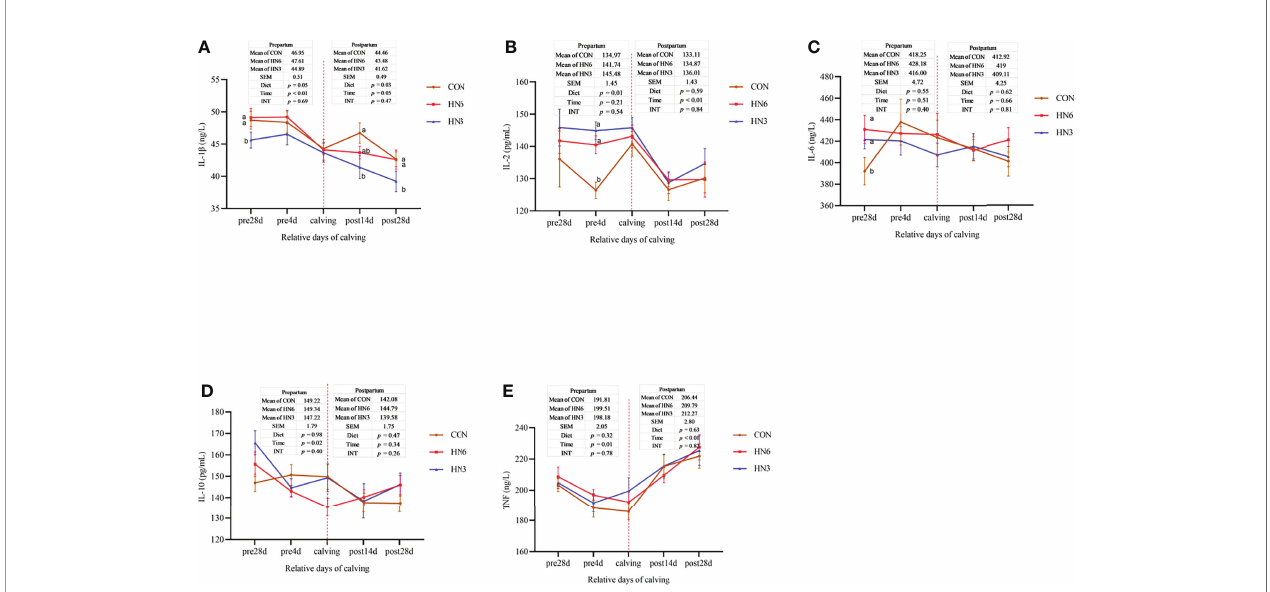
FIGURE 5 | Blood in fl ammatory cytokines in maternal cows. CON: control treatment (saturated fatty acid source), n = 12. HN3: extruded fl axseed treatment (n-3 PUFA source), n = 12. HN6: extruded soybean treatment (n-6 PUFA source), n = 13. SEM, standard error of the mean; Diet, diet treatment effect; Time, the calving time effect; INT, the interaction effect between diet effect and time effect. IL, interleukin; TNF, tumor necrosis factor. (A – E) : the different blood in fl ammatory cytokines in maternal cows. Values in the same sampling time point between treatments denoted by different superscript lowercase letters indicate signi fi cant differences ( p < 0.05), whereas those denoted by the same letters or no letters are not signi fi cantly different ( p >